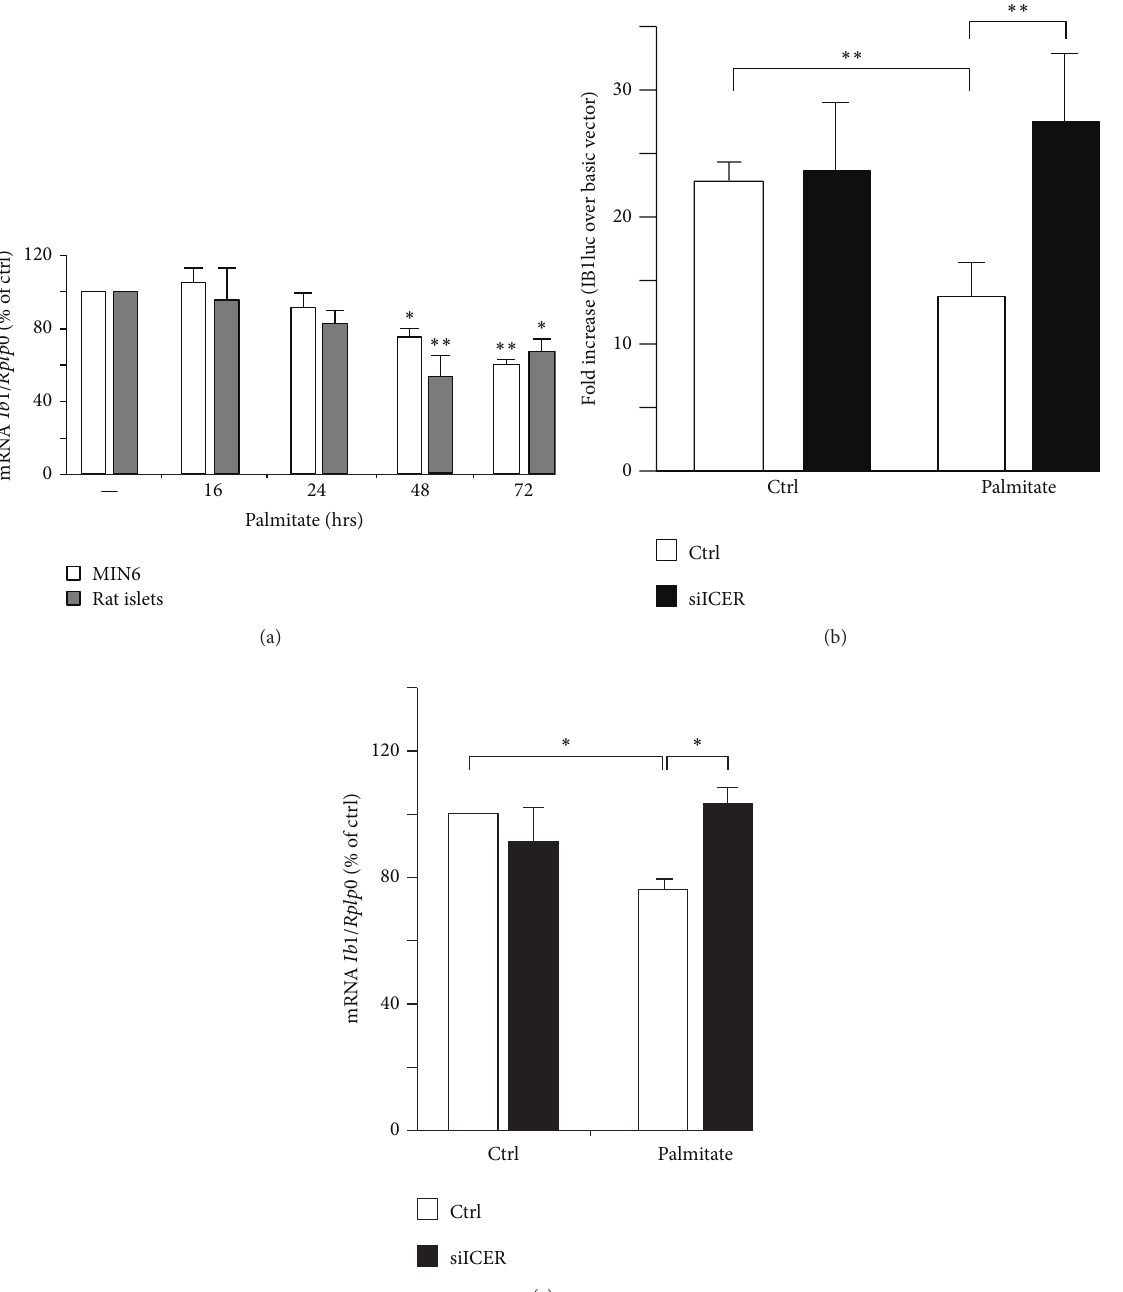
Figure1:Effectofpalmitateonthe Ib1 mRNAlevel.(a)Quantificationof Ib1 mRNAlevelbyRT-qPCRfromMIN6cells( openbar